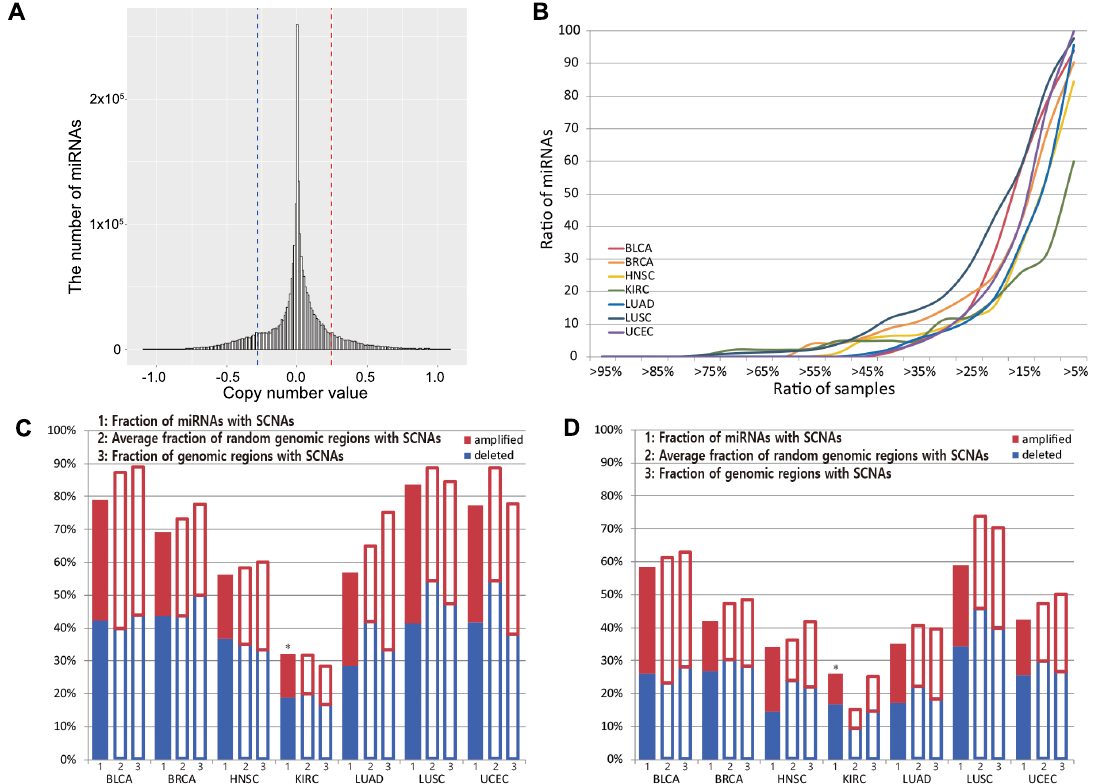
Figure 1. Characteristics of miRNAs with copy number alterations. ( A ) Copy number distribution of miRNA gene regions. Red and blue dashed lines show copy number amplification or deletion thresholds, respectively. ( B ) On the x axis, the fraction of samples containing somatic copy number alterations (SCNAs) is represented. On the y axis, the fraction of miRNAs with SCNAs is presented when an miRNA was declared to be located in the SCNA region if the fraction of samples with SCNAs was larger than the given fraction value on the x axis. ( C ) The ratio of miRNAs with SCNAs in > 10% of samples of each cancer type. ( D ) The ratio of miRNAs with SCNAs in > 15% of samples of each cancer type. In ( C , D ), red and blue bars represent the percentage of miRNAs with copy number amplifications or deletions, respectively. These ratios were compared to those of SCNAs in randomly selected regions and all genomic regions. “*” indicates that the fraction of miRNAs in the SCNA regions was significantly larger than the fraction of random genomic regions with SCNAs for the